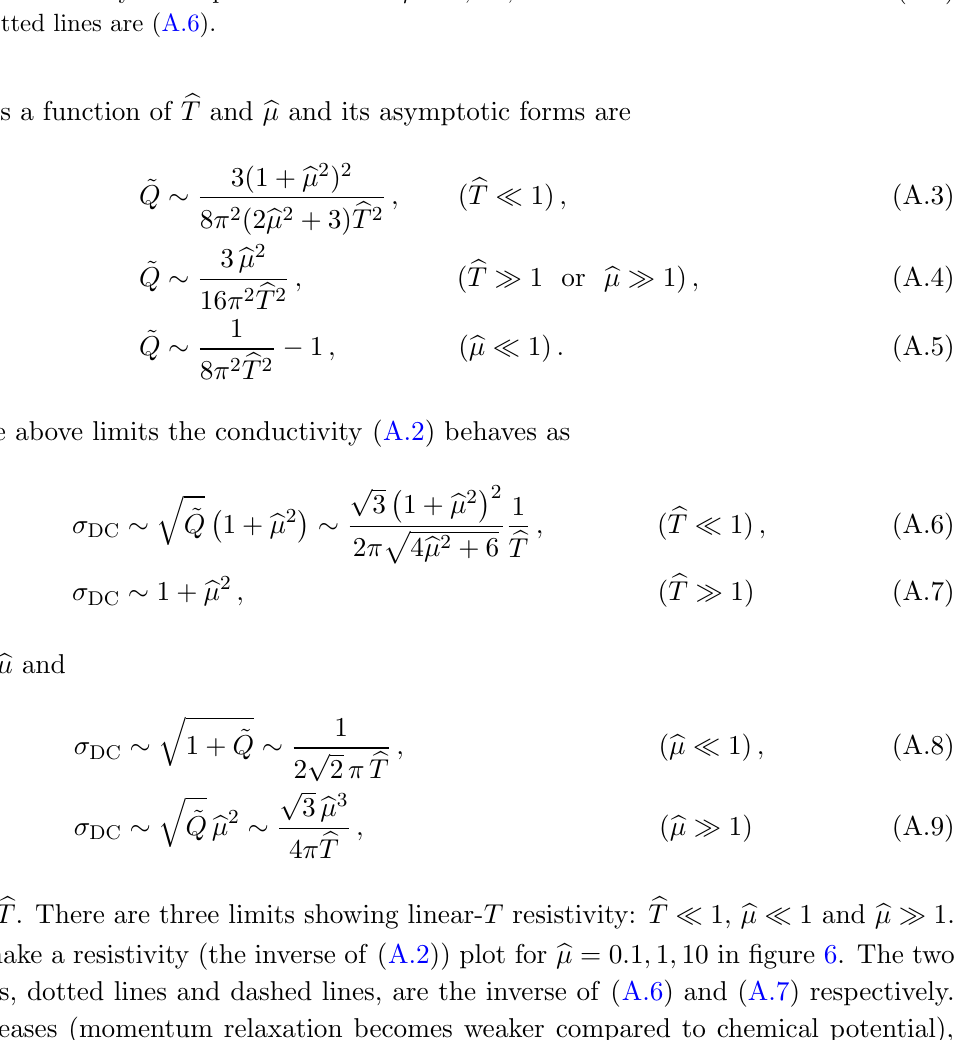
(cid:22) = 0 ; 0 : 1 ; 1. The horizontal dashed lines are (A.7) b